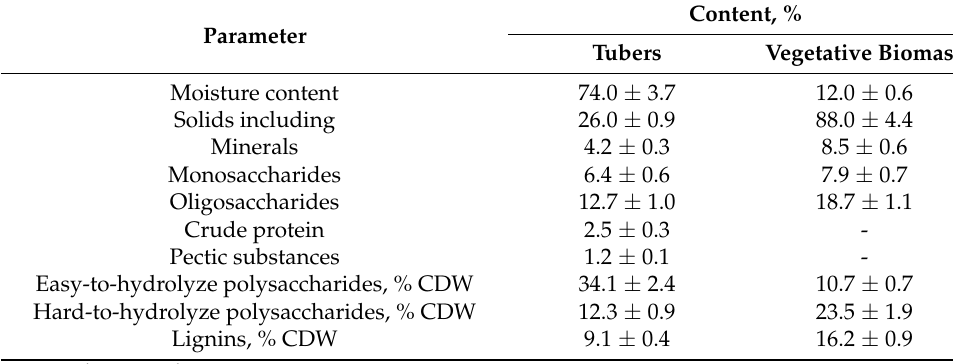
Table 1. Chemical composition of Jerusalem artichoke cv. Interes.